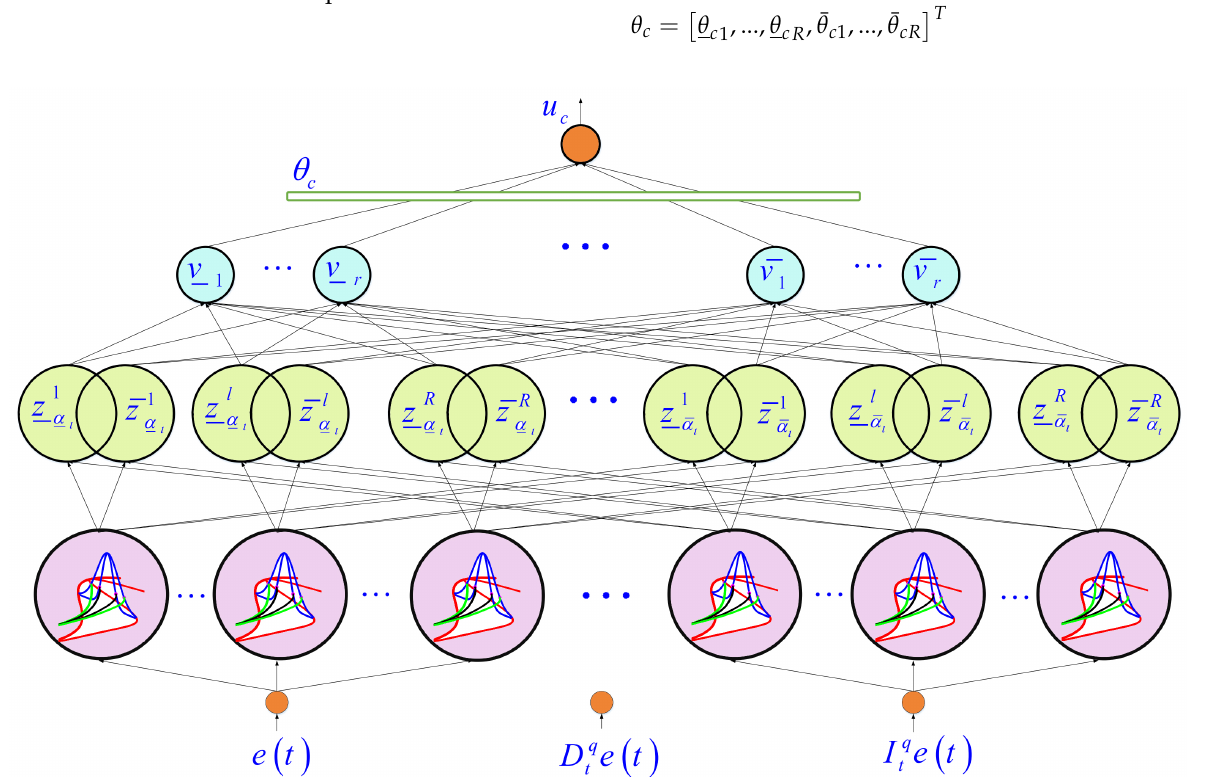
Figure 5. The suggested interval type-3 FLS block